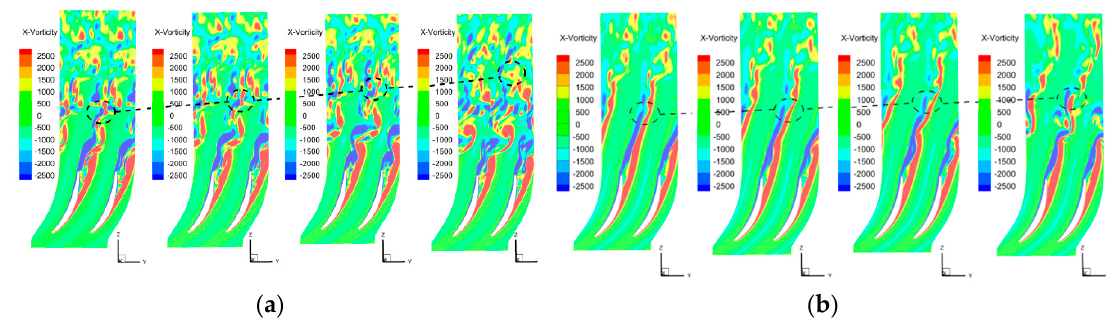
Figure 9. Contour of spanwise vorticity at different times: ( a ) 20% span from t1 to t4; ( b ) 10% span from t1 to t4.